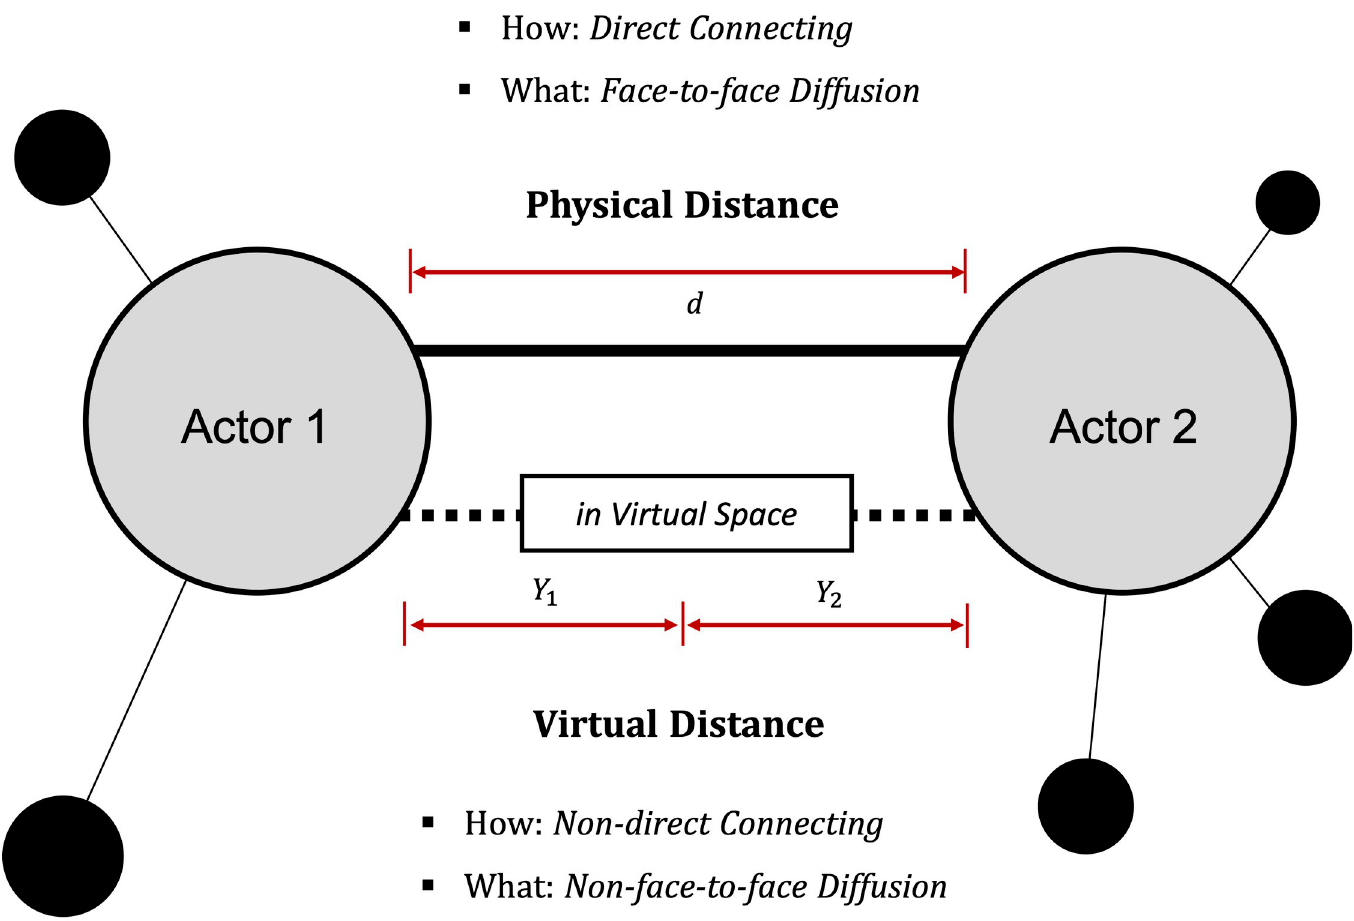
Fig 2. AP factors for distinguishing the physical from the virtual: Physical vs. virtual distance; direct vs. non-direct connecting; and face-to-face vs. non-face-to-face diffusion.